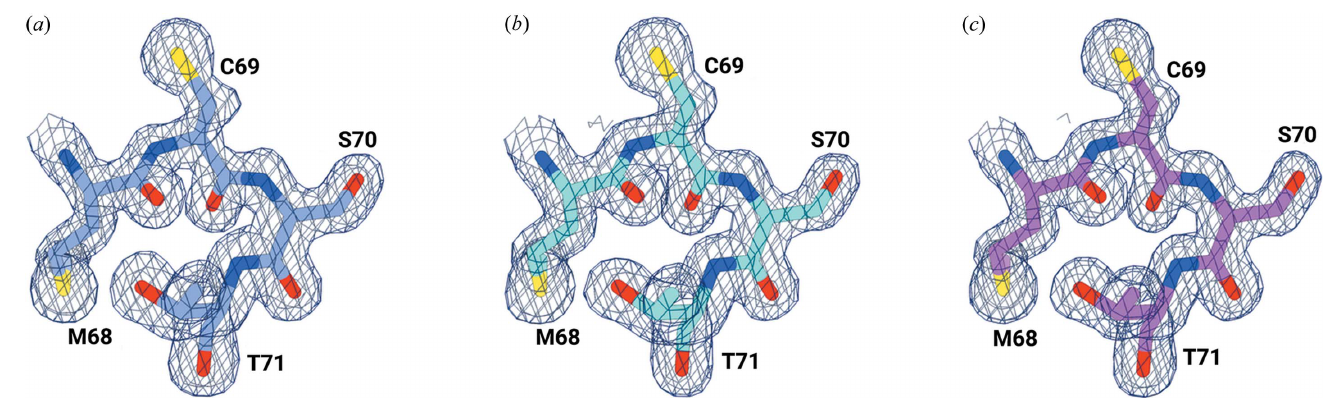
Figure 2 Selected residues of CTX-M-14 (cid:2) -lactamase around the active center and overlayed with the corresponding 2 mF o (cid:2) F c maps contoured each at 1.5 (cid:5) . ( a ) 10000 detector images (10k), ( b ) 5000 detector images (5k), ( c ) full dataset (127171 detector images). For ( a ) and ( b ) data out to 1.55 A˚ were used, for ( c ) the CC* statistics indicated that data out to 1.4 A˚ could be used. No significant differences between the electron density maps are visible.